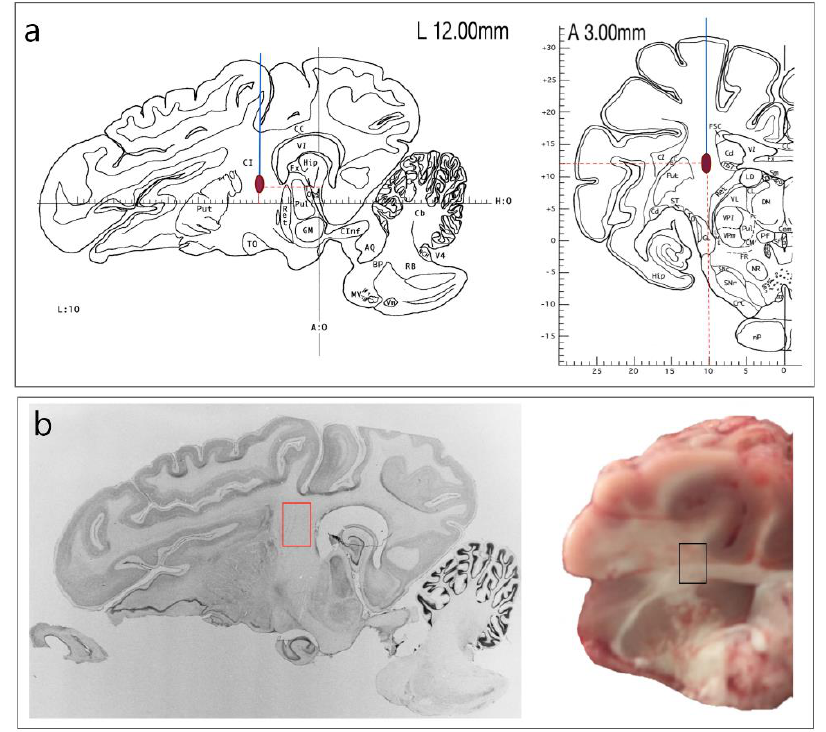
Figure 1. Model of intracerebral hemorrhage: ( a )—stereoscopic model for simulating acute hemor- rhagic stroke in the internal capsule [8]; ( b )—location of brain